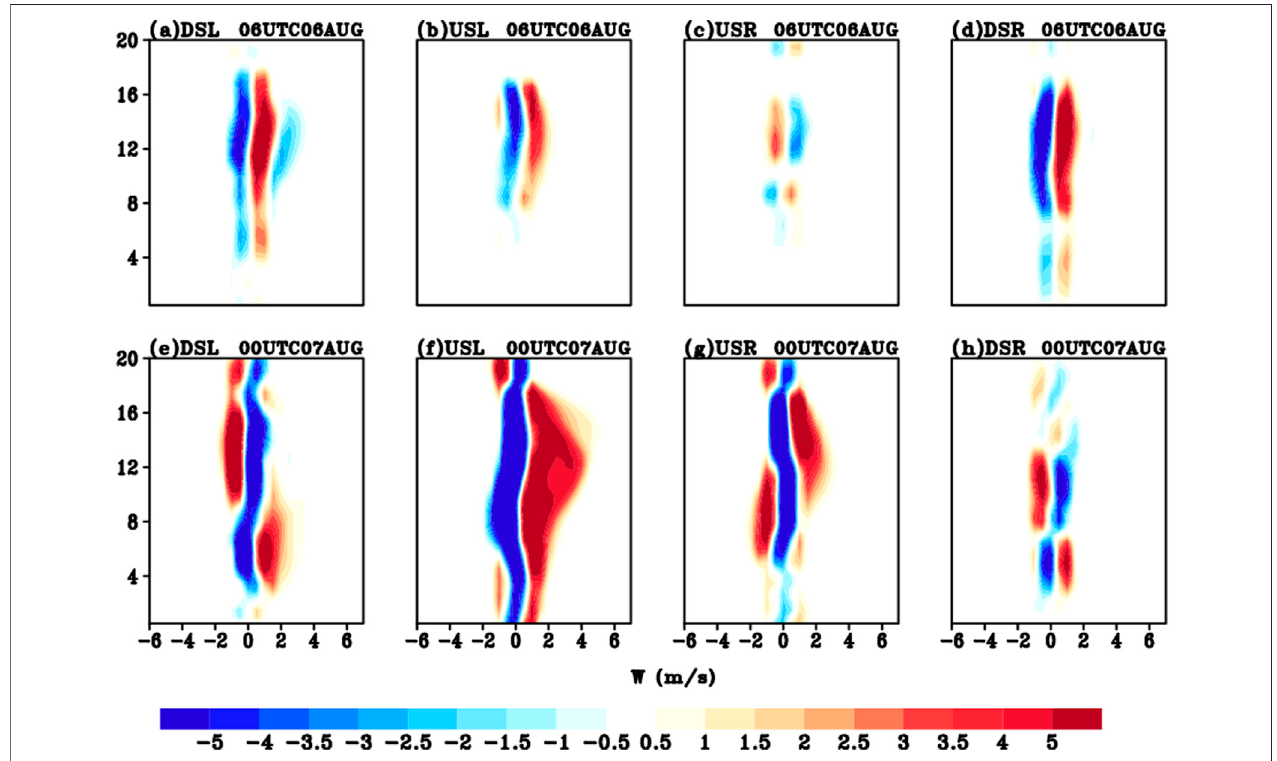
FIGURE 7 | The differences of CFADs of vertical velocity (units: %) for each shear quadrant between CTL and noR at 06 UTC 6 and 00 UTC 7 August.